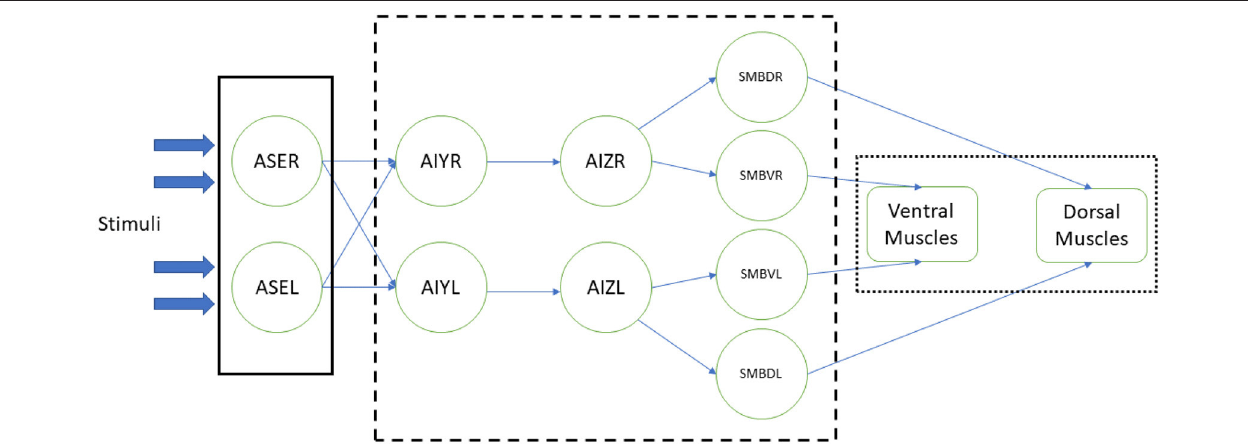
FIGURE 1 | Example of a neural stimulation of the C. elegans (Izquierdo and Beer, 2015). Response to chemical sensation was modeled at three stages: the sensory input, the processing of the stimuli by a simplified neural network, actuation of the muscles that result in the worm’s motion. Stimulation (plain box) of ASE chemosensory neurons is obtained via an instantaneous function of a derivative operator applied to the recent history of attractant concentrations. Neural circuit (dashed box), with AIY and AIZ interneurons and SMB motorneurons, is connected via sigmoidal synapses. Dorsal and ventral muscles (dotted box) are based in the work of Boyle et al.